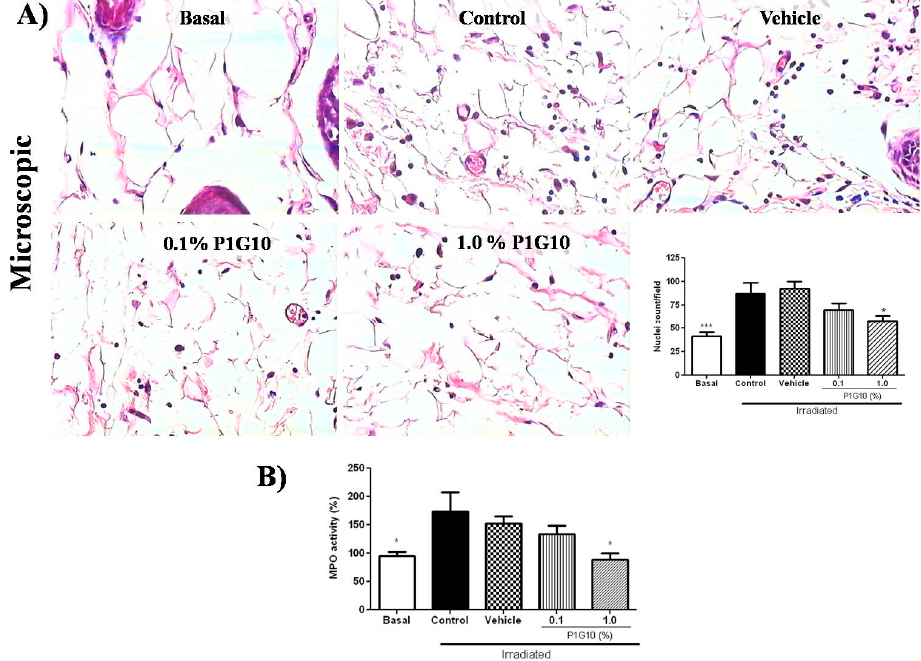
Figure 5. The effect of P1G10 on the infiltration of inflammatory cells in UVB-irradiated mice. Biopsies were preserved in 10% buffered formalin for histological and morphometric analysis. ( A ) Photomicrographs illustrate the nuclei density of hypodermis in slides stained with H&E (40x objective): Basal, control, vehicle, 0.1% and 1.0% P1G10. The data quantifies hypodermal nuclei from the image. ( B ) Infiltrating neutrophils were quantified by myeloperoxidase assay (MPO). Results represent the mean ± SEM of 6–8 animals per group (* p < 0.05 and *** p < 0.001 di ff erence versus vehicle, ANOVA, Newman–Keuls